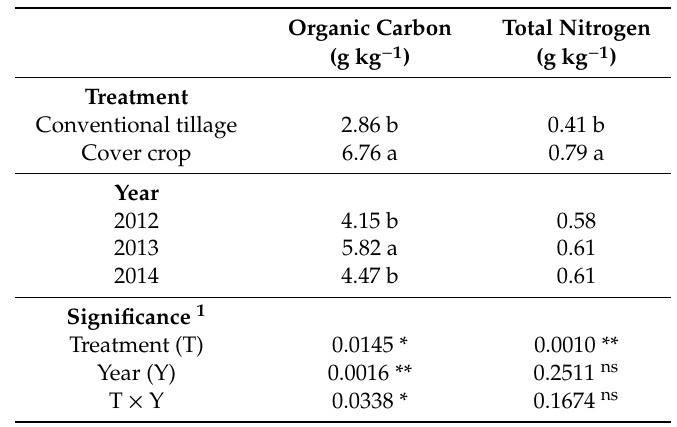
Table 2. Effect of the soil management system (treatment), growing season (year) and their interaction (treatment × year) on organic C and total N content of soil.